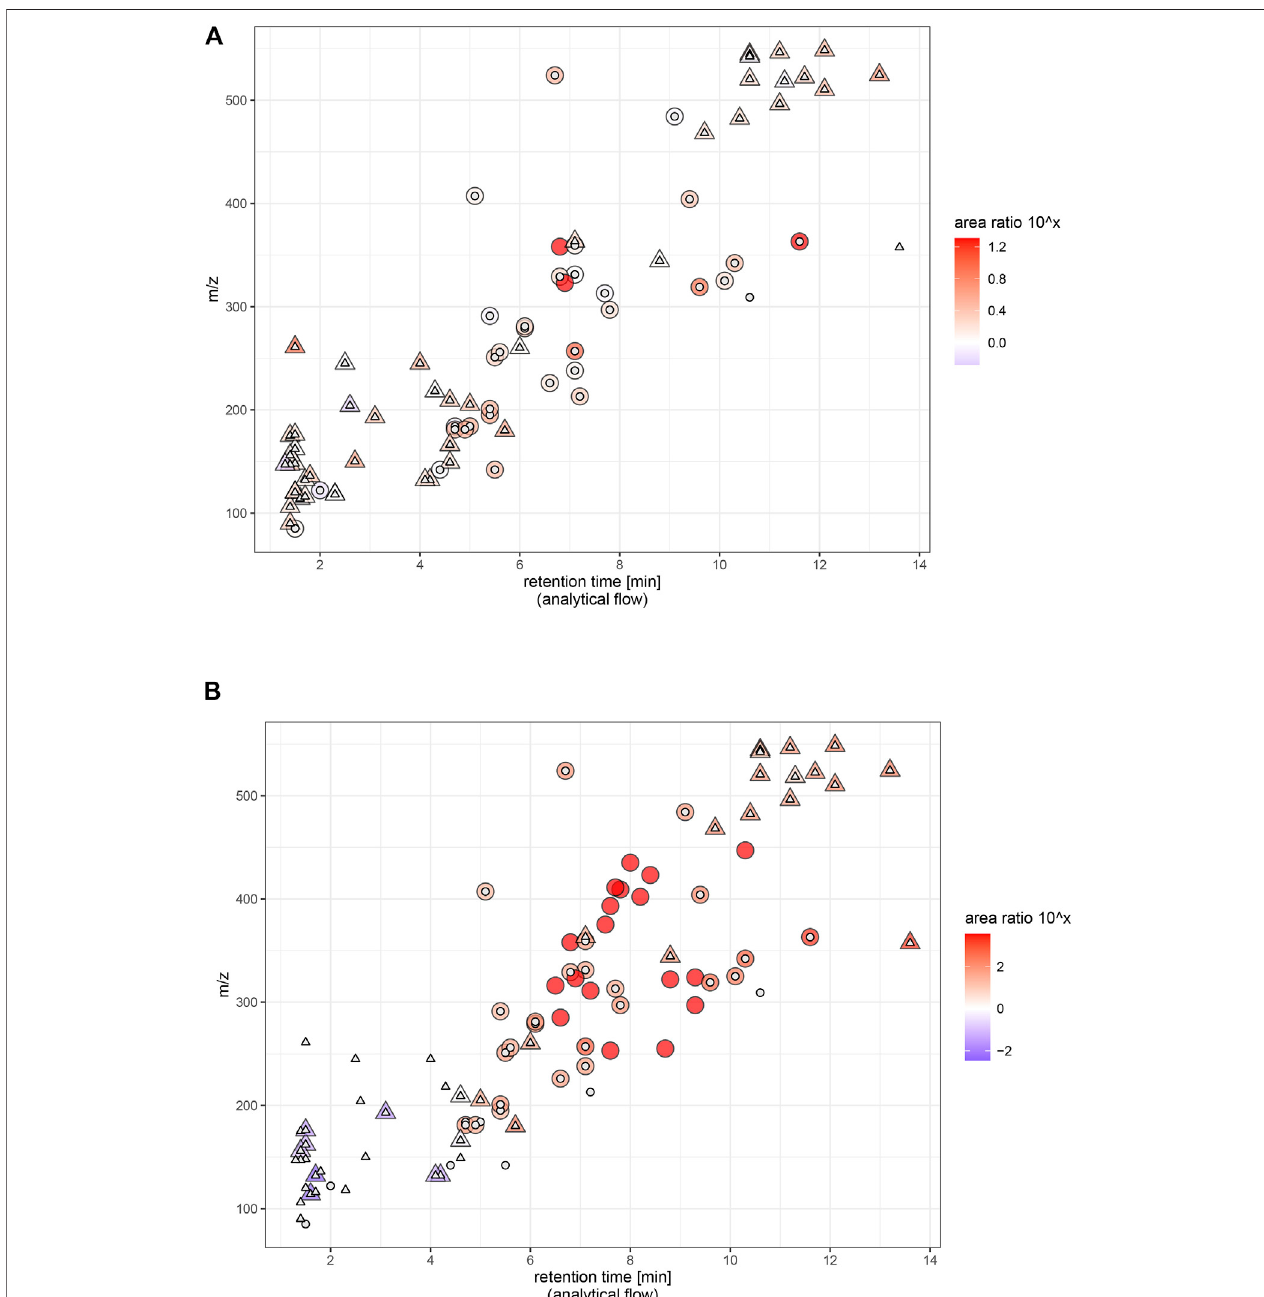
FIGURE 6 | Signal intensity (relative) and physicochemical coverage. Endogenous and exogenous molecules (ceftiofur and coumaphos 10 μ g/L, caffeine, paraxanthineandtheobrominenaturallyoccuringabundance,allothers1 μ g/L)inplasmaextract.Panel (A) micro,panel (B) nano.Ratio=areainminiaturizedsetup/area inanalytical fl owsetup.Trianglesrepresentendogenousmetabolites,circlesrepresentexogenousanalytes.Largeicon=moleculehasbeenfoundinminiaturizedsetup, smallicon: molecule has been found inanalytical fl owsetup.Areas are background corrected.LPC 20:1 was excluded to facilitate visual comparison (ratio ~6,000 in nano and ~200 in